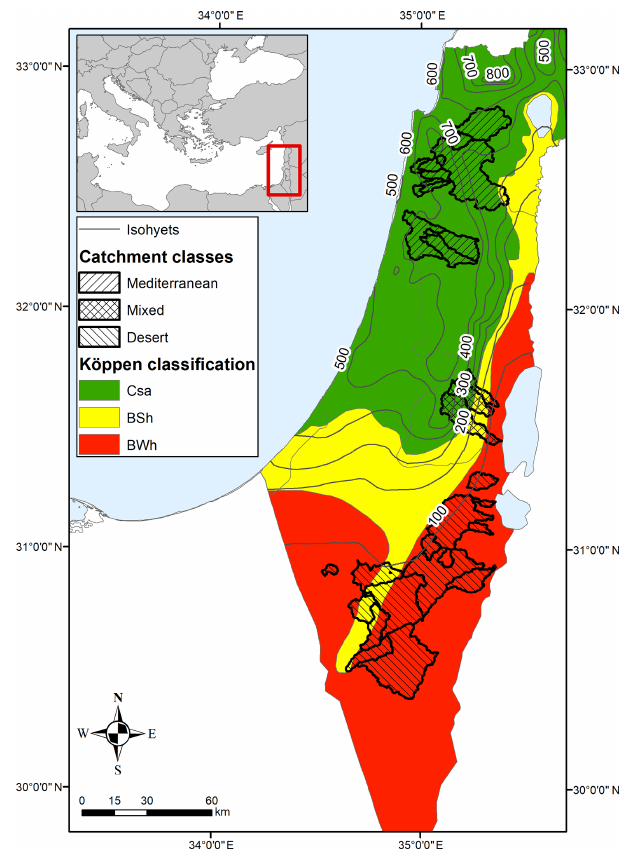
Figure 1. Köppen–Geiger climate classification from Survey of Is- rael (1970), mean annual precipitation (1981–2010, Israel Meteoro- logical Service) and catchment climatic